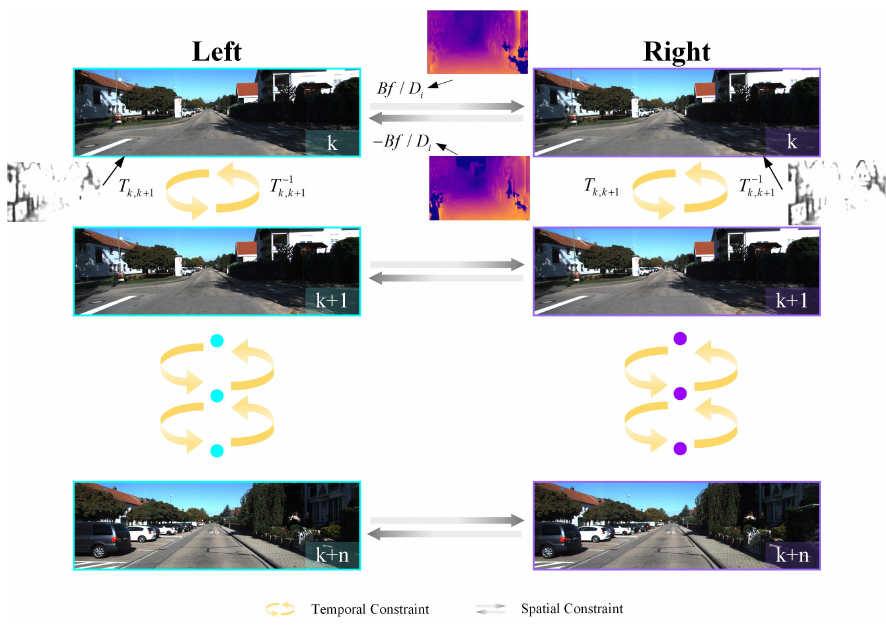
Figure 3. Construction of loss